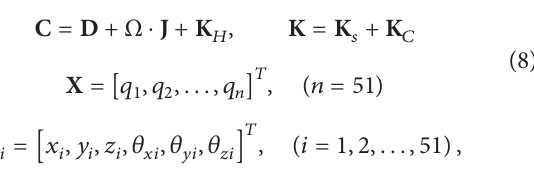
holder, and R245 milling cutter. The FEM model of high- speed spindle system is discretized with different inner or outer diameters, bearing locations, spindle-holder taper joint, and holder-tool cylindrical joint shown in Figure 8. The bolts and lubrication are neglected. The five supporting bearings Figure 5: Schemes of parallel rotors assembly. are installed in two pairs and the middle is independent. The dots in Figure 9 represent mass point; the small sections represent unit. There are 52 units and 53 nodes in the FEM including 2 transition sections. The external forces on the right consist of spindle-bearing forces, spindle-holder- tool joints hysteretic forces, and cutting force on the tool point. The dynamic equation of high-speed spindle system could be expressed